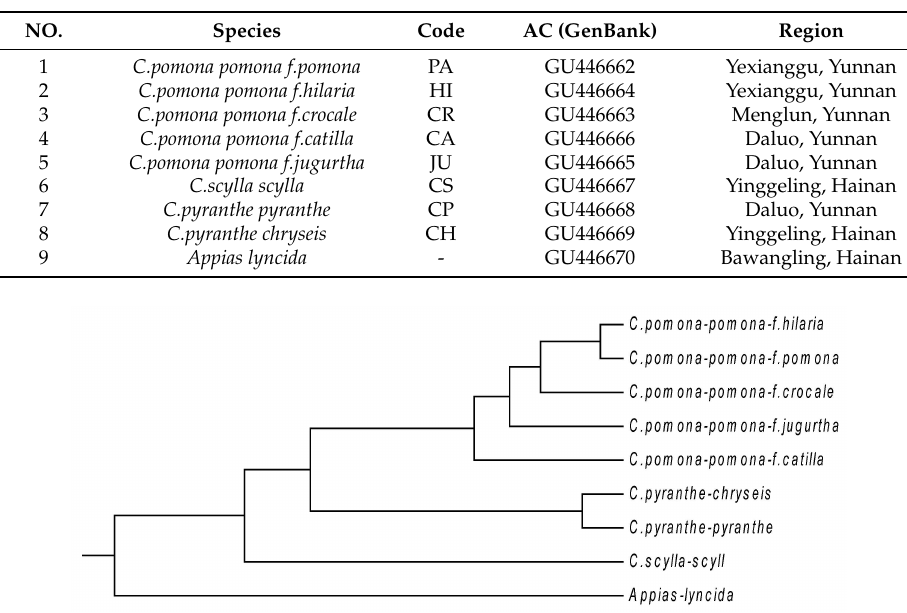
Table 4. The COI (cytochrome oxidase subunit I) genes of nine butterflies.